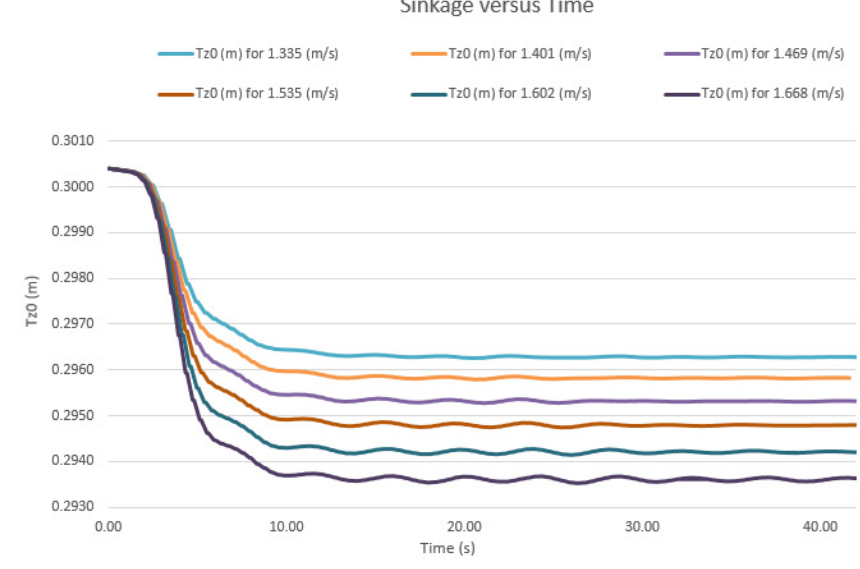
Figure 8. Sinkage for all speeds computed.